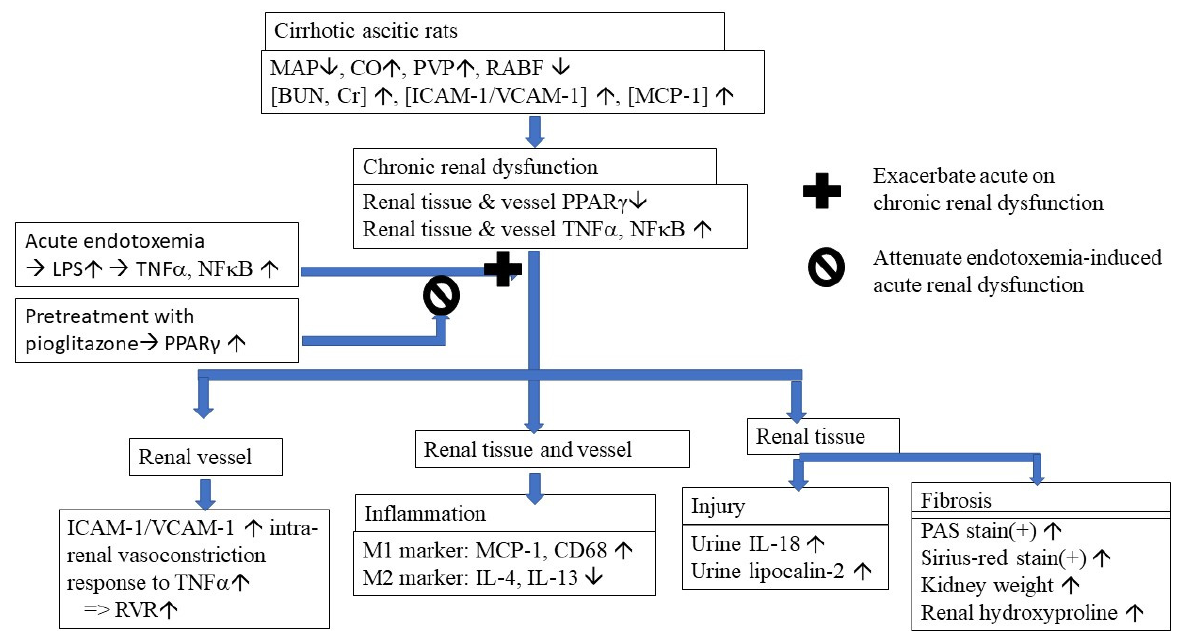
Figure 6. Graphical summary of the pathogenic mechanisms and effects of restoration of renal tissue and vessels PPAR with pioglitazone on the endotoxemia-induced acute on chronic renal dysfunction in cirrhotic rats. MAP: mean arterial pressure; CO: cardiac output; PVP: portal venous pressure; RABF: renal arterial blood flow; ICAM-1: intercellular adhesion molecule 1; VCAM-1: vascular cell adhesion molecule 1; MCP-1: monocyte chemoattractant protein 1; PPAR γ : peroxisome proliferator-activated receptor gamma; TNF α : tumor necrosis factor alpha; NFkB: nuclear factor kappa-light-chain-enhancer of activated B cells; LPS: lipopolysaccharide; RVR: renal vascular resistance; M1/M2: two types of macrophages; PAS stain: periodic acid ‐ Schiff stain.